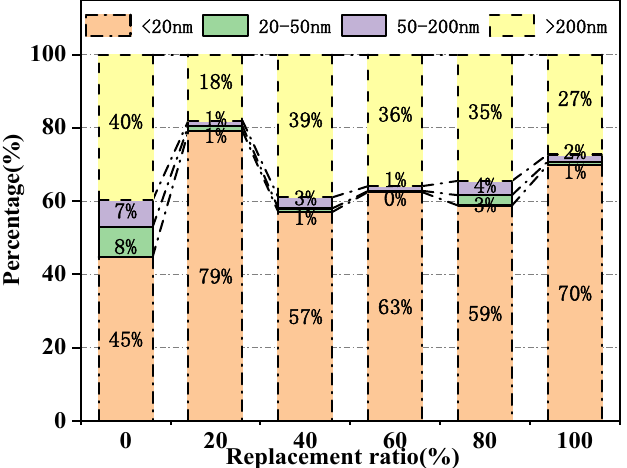
Figure 11. Pore size distribution histogram of MUHPC.